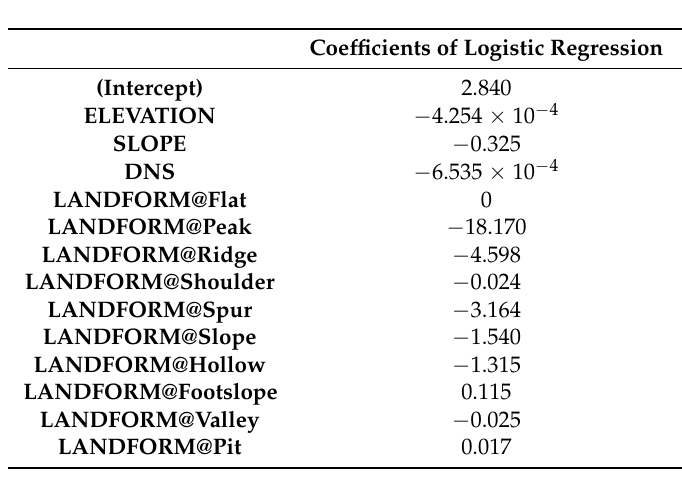
Table 3. Logistic regression